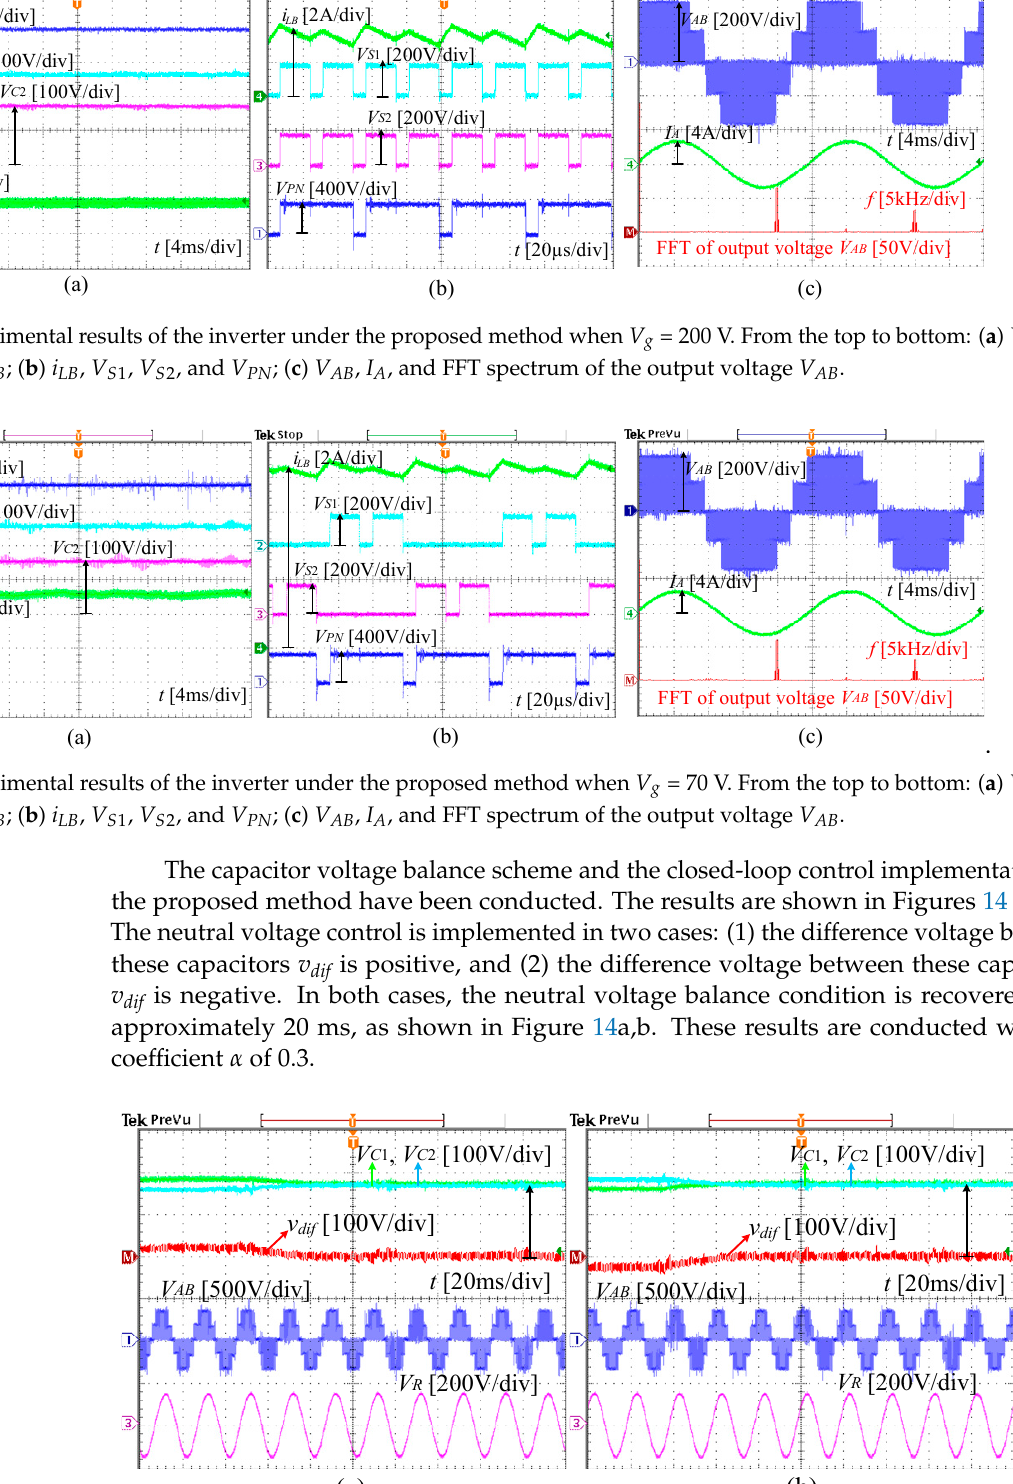
Figure 11. Experimental prototype.